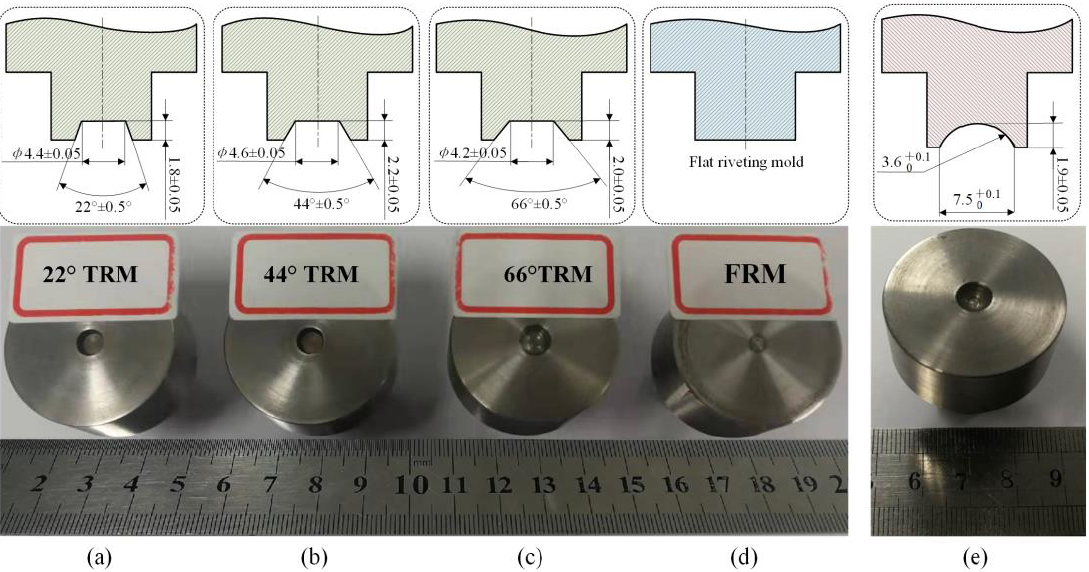
Figure 9. Dimensions and products of different riveting molds: ( a ) 22° TRM, ( b ) 44° TRM, ( c ) 66° TRM, ( d ) FRM, ( e ) ARM.